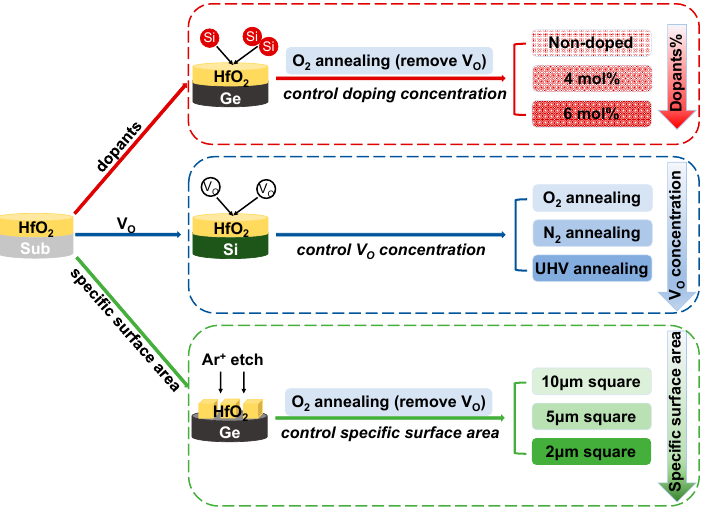
Figure 1. The process for independent control of doping concentration, V O concentration, and specific surface area in HfO 2 thin film.